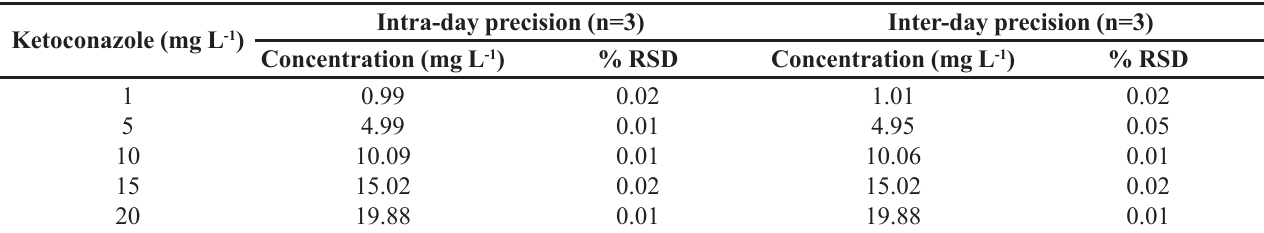
TABLE II - Precision study for ketoconazole Ketoconazole (mg L -1 )